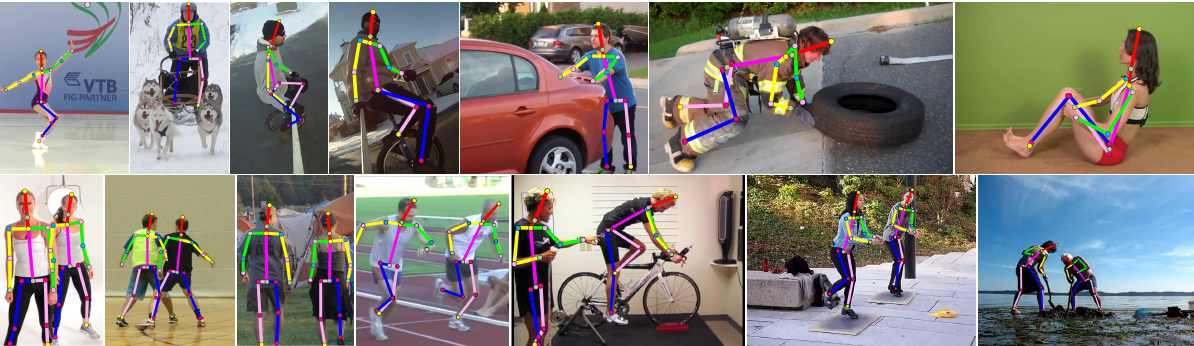
Figure 7. Presentation for MPII: including viewpoint change, occlusion, and multiple persons. Implementation Details. Our experiments were trained on 4 NVIDIA A100 GPUs with PyTorch 1.9, CUDA 11.1, and cuDNN 8.0.5. For the system, it was a Ubuntu 16.04 running on an Intel E5-2678v3@2.50 GHz CPU and 64 G RAM